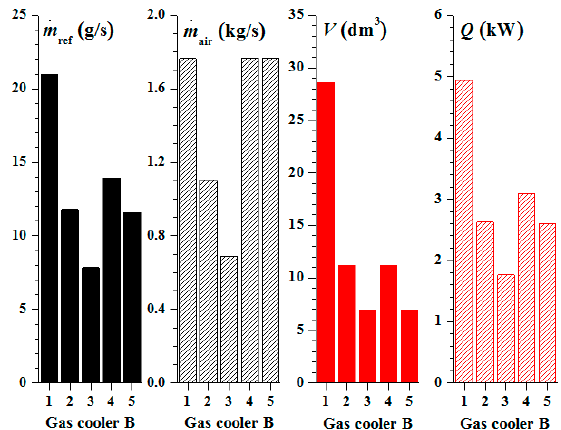
· · m ref , m air , V, and Q